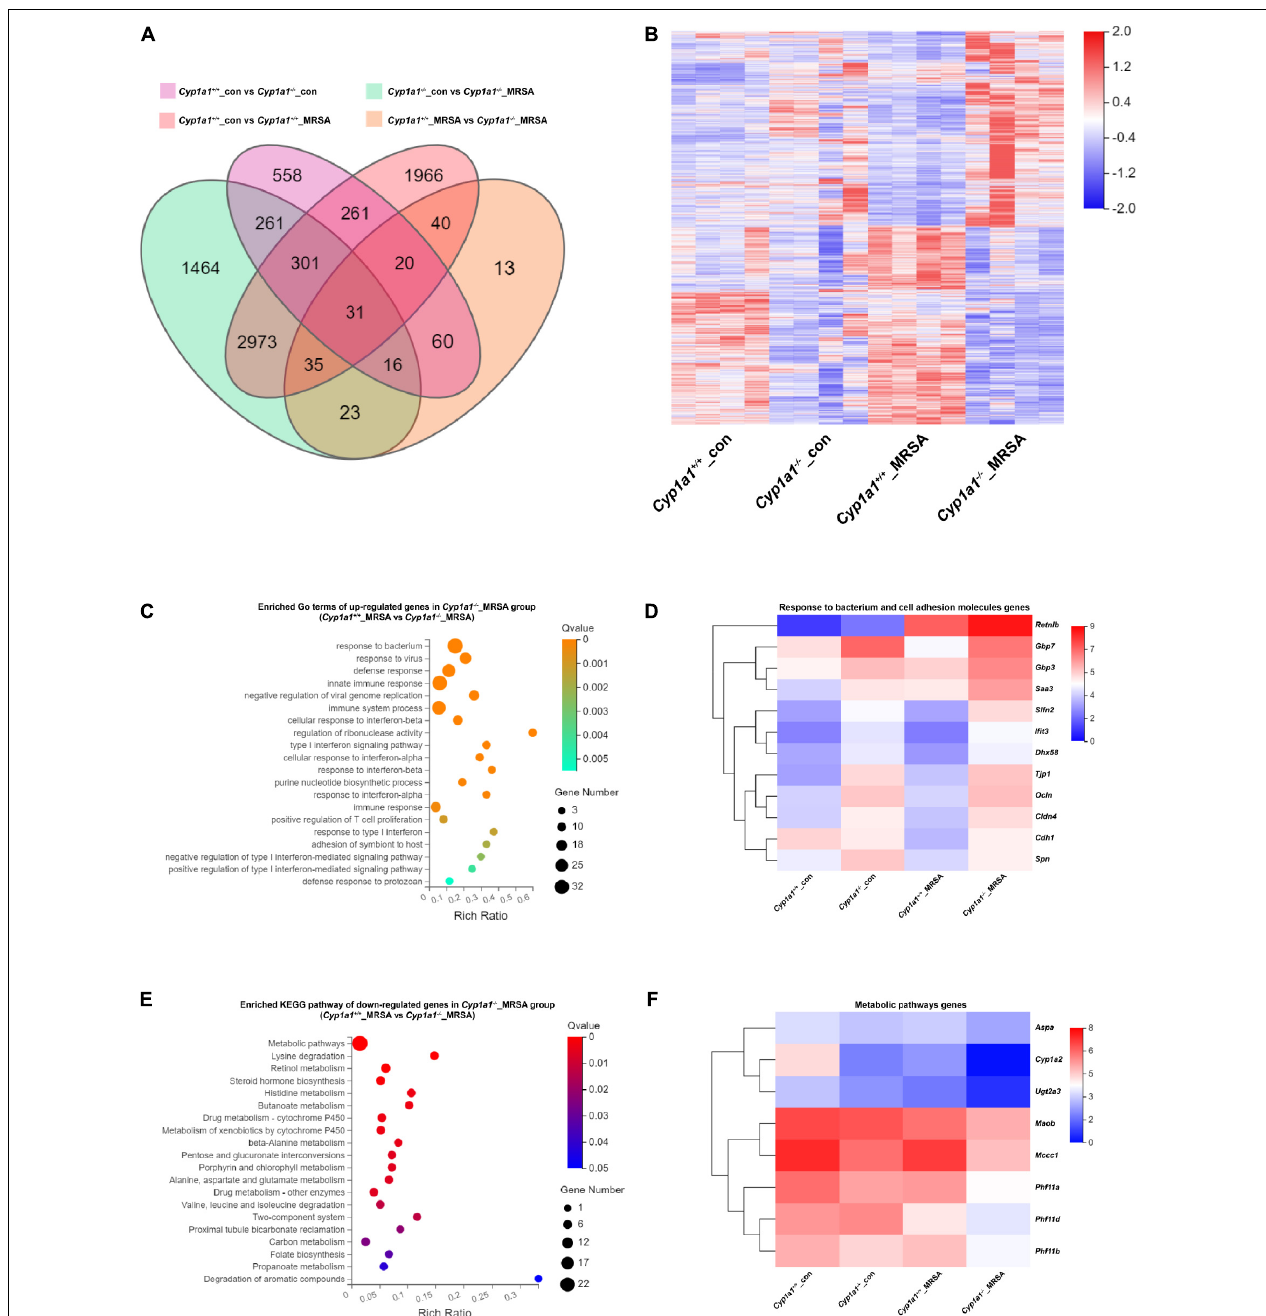
FIGURE 2 | Ileum RNA profile comparison between Cyp1a1 + / + mice and Cyp1a1 − / − mice at 12 h p-Mi. (A) Venn diagram summarizing the expression of genes in ileum tissues from Cyp1a1 + / + mice and Cyp1a1 − / − mice with or without MRSA infection, as determined by RNA-seq data. (B) Heatmap of the differentially expressed genes (DEGs) in ileum tissues from mice as in (A) . (C) Functional annotation of genes by the top 20 gene ontology (GO) terms upregulated in Cyp1a1 − / − mice at 12 p-Mi. (D) Heatmap of the expression of the DEGs encoding bacterial response and cell adhesion molecules. (E) Functional annotation of genes by the top 20 Kyoto Encyclopedia of Genes and Genomes (KEGG) pathways downregulated in Cyp1a1 − / − mice at 12 h p-Mi. (F) Heatmap of the expression of the DEGs encoding metabolic pathways.